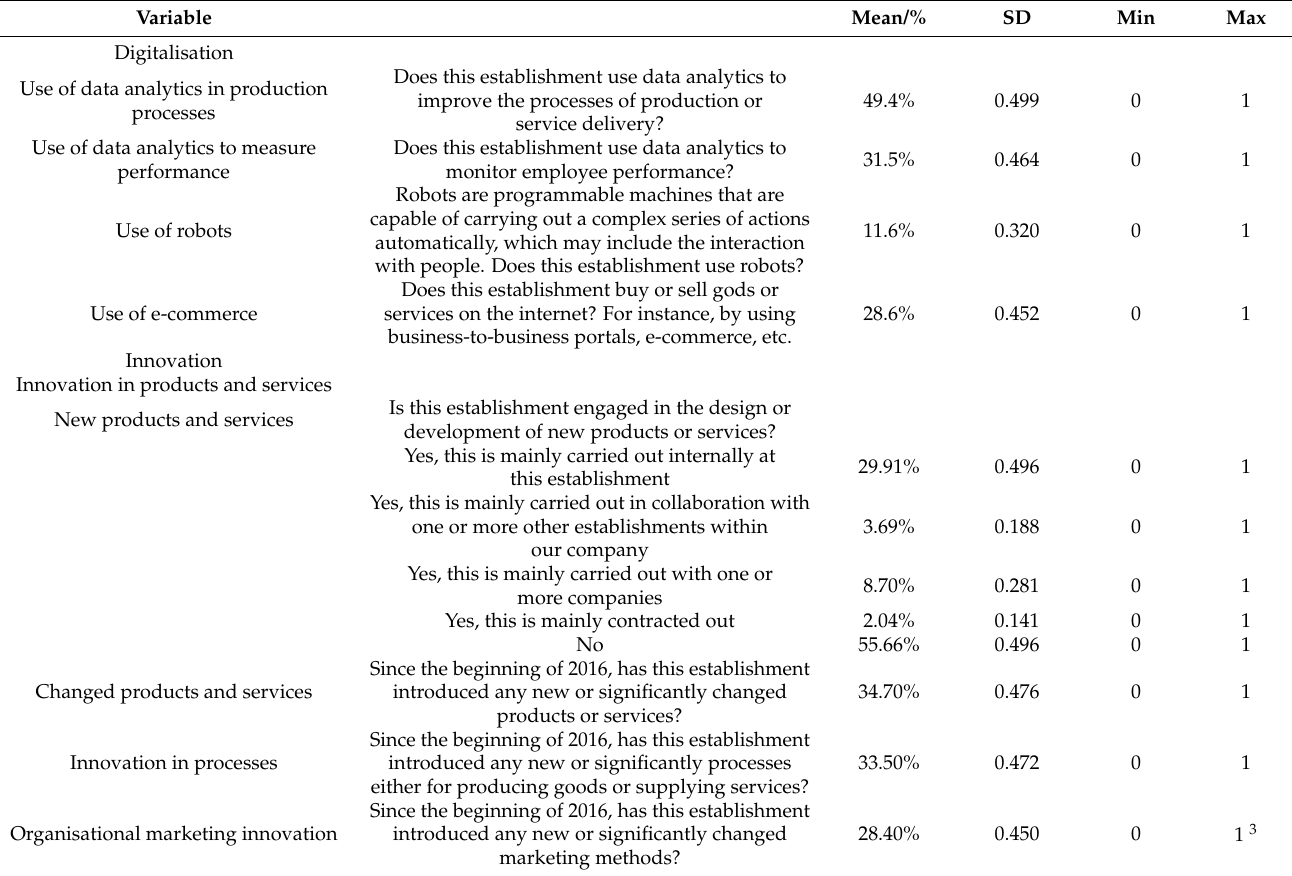
Table 3. Digitalisation and innovation data across Europe in